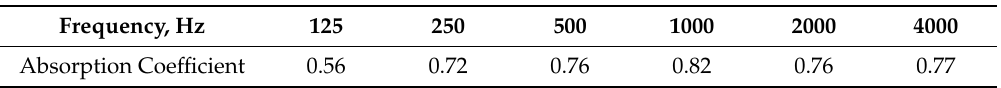
Table 3. Sound absorption coefficient values of the empty seats.